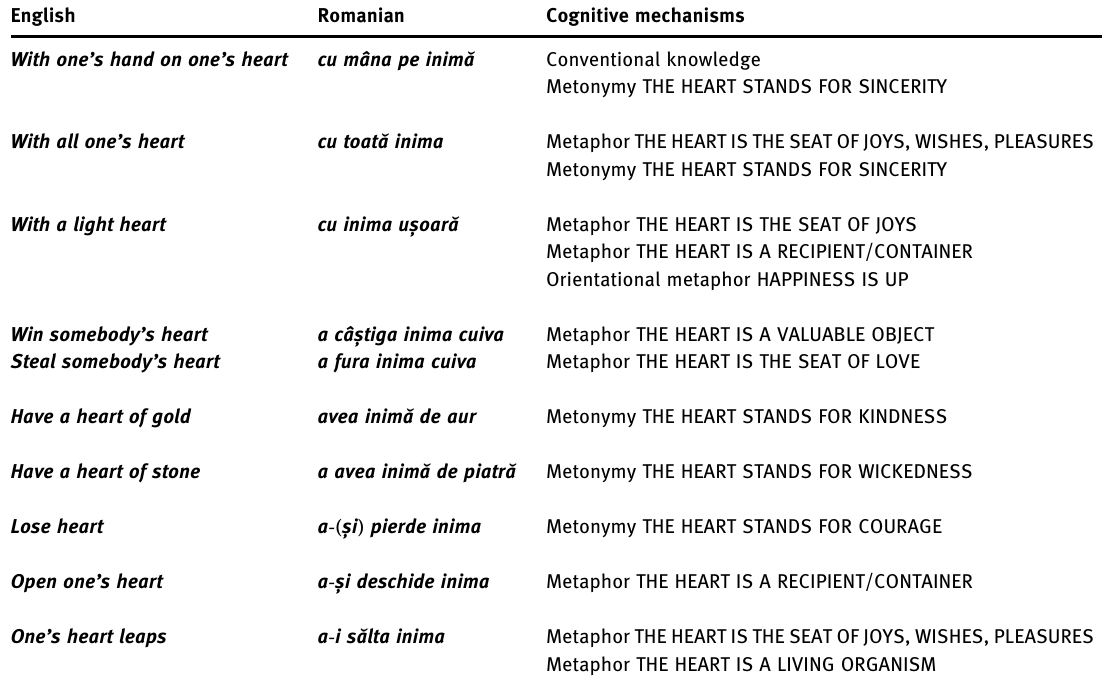
Table 1: English heart idioms and their Romanian equivalents of similar meaning and form English Romanian Cognitive